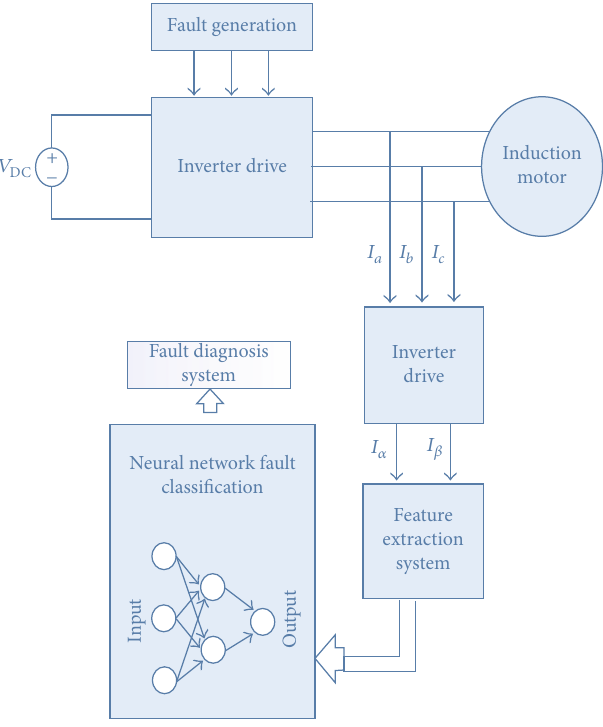
Figure 1: Fault detection and diagnosis